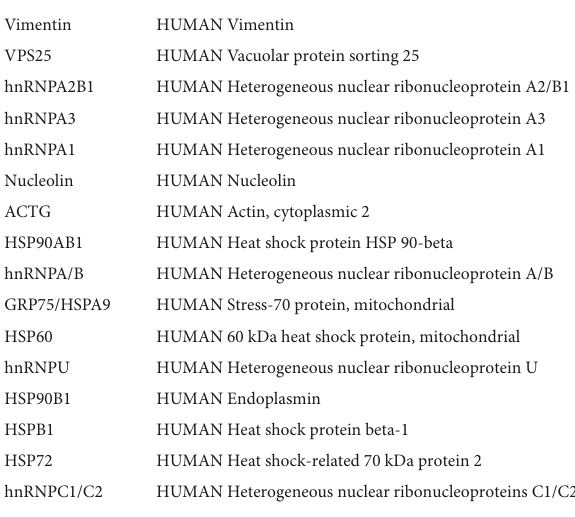
TABLE 2 List of potential proteins interacting with EV71 3A